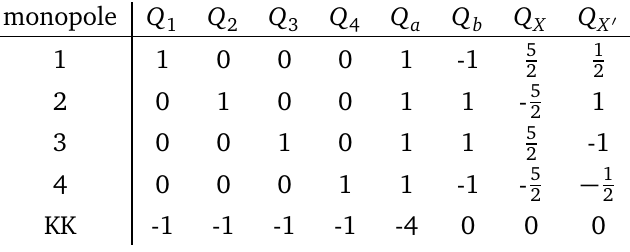
Table 3: Charges of the various SU ( 5 ) monopoles on R 3 × S 1